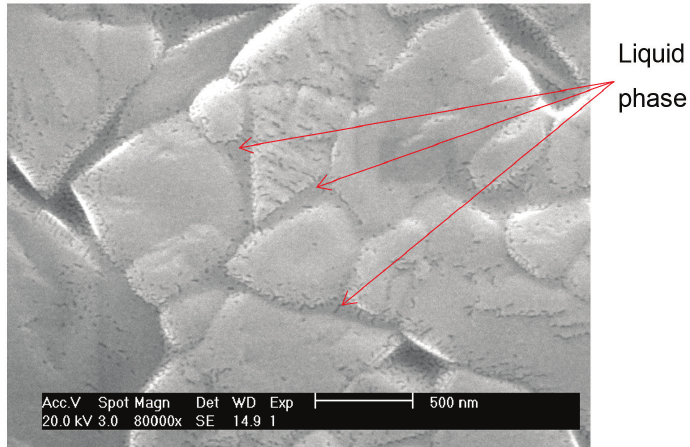
Figure 4. SEM micrographs of composition S sintered at 2.1 kW for 20